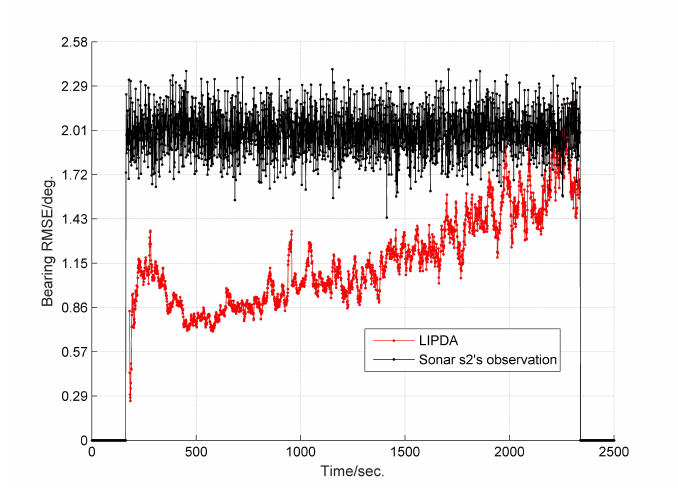
Figure 5. RMSE of estimated target bearing and the raw bearing observed by sonar s 2 at case